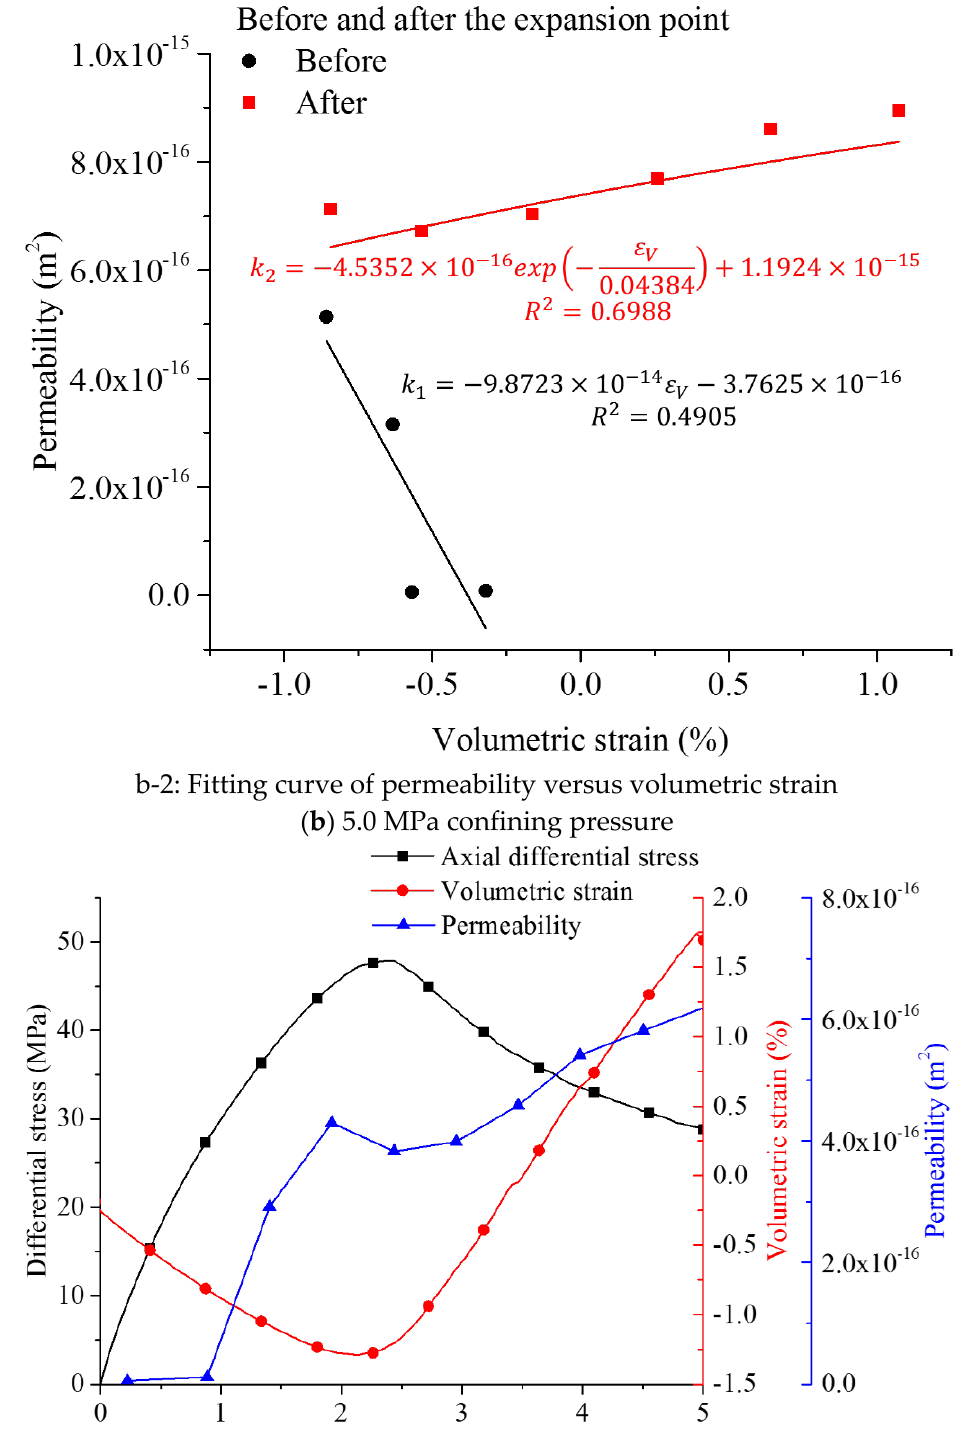
c-1: Differential stress, volumetric strain and permeability evolutions Figure 19. Cont